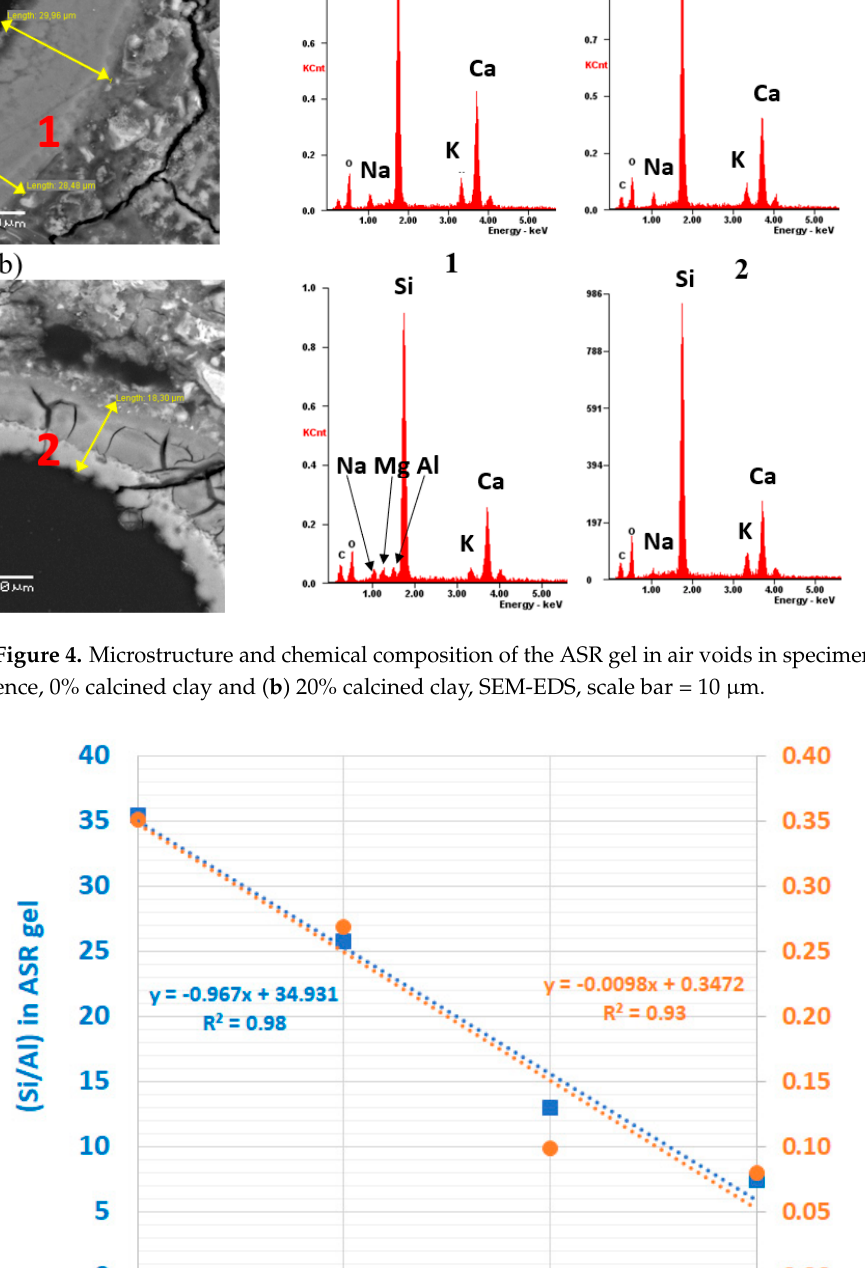
Figure 5. The relationship between the ASTM C1567 expansion and the Si/Al ratio in the ASR gel in relation to the content of the calcined clay cement substitute.